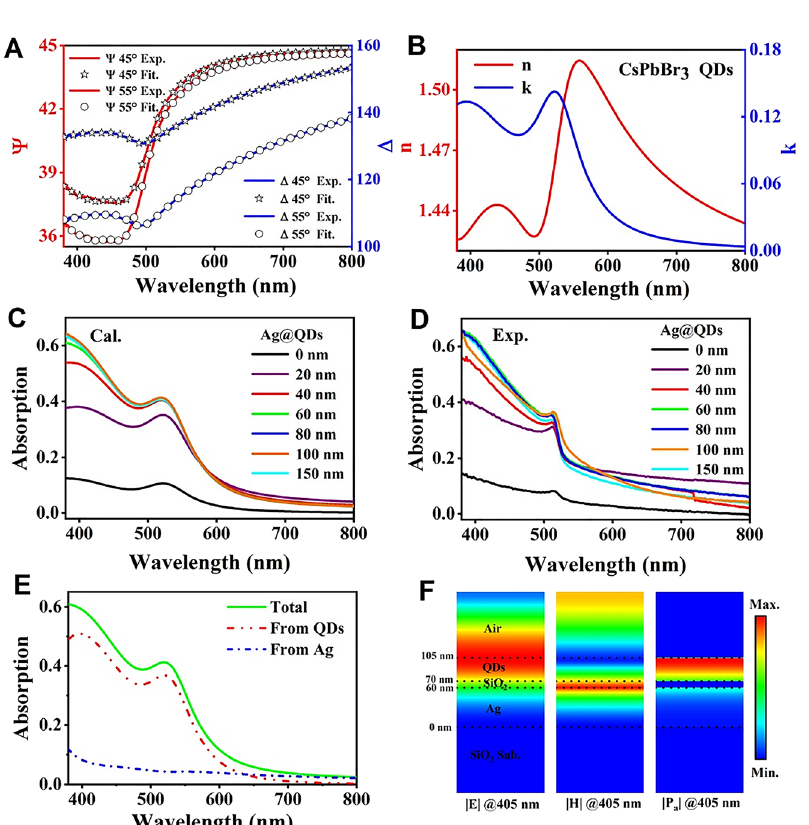
Figure 3: Ellipsometry analysis and